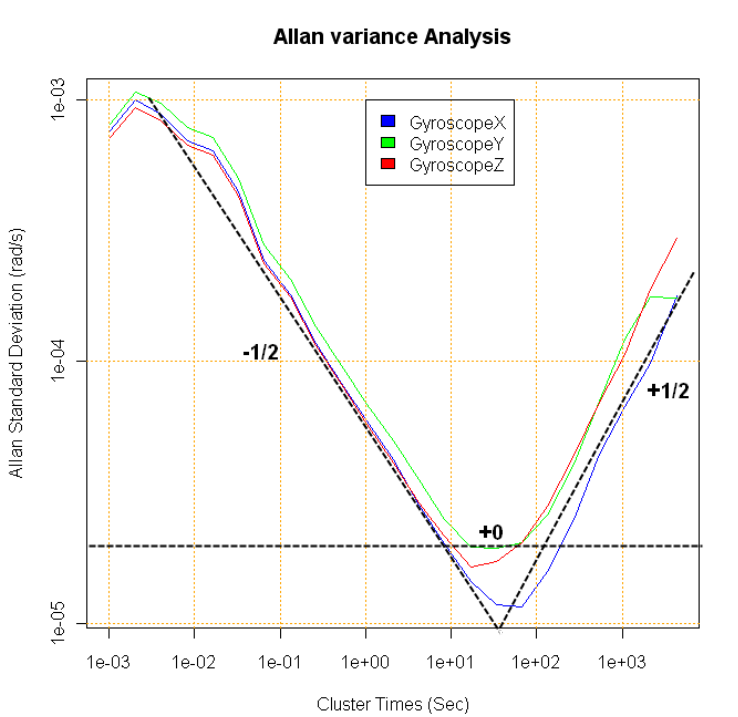
Figure 5. Allan variance analysis for IMT30